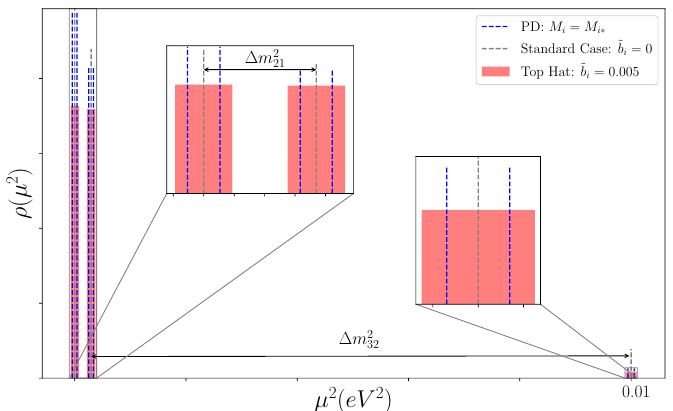
Figure 4. Evaluation of the top-hat phenomenological ansatz defined in section 2.5 to capture the oscillation behaviour of pseudo-Dirac models as detailed in section